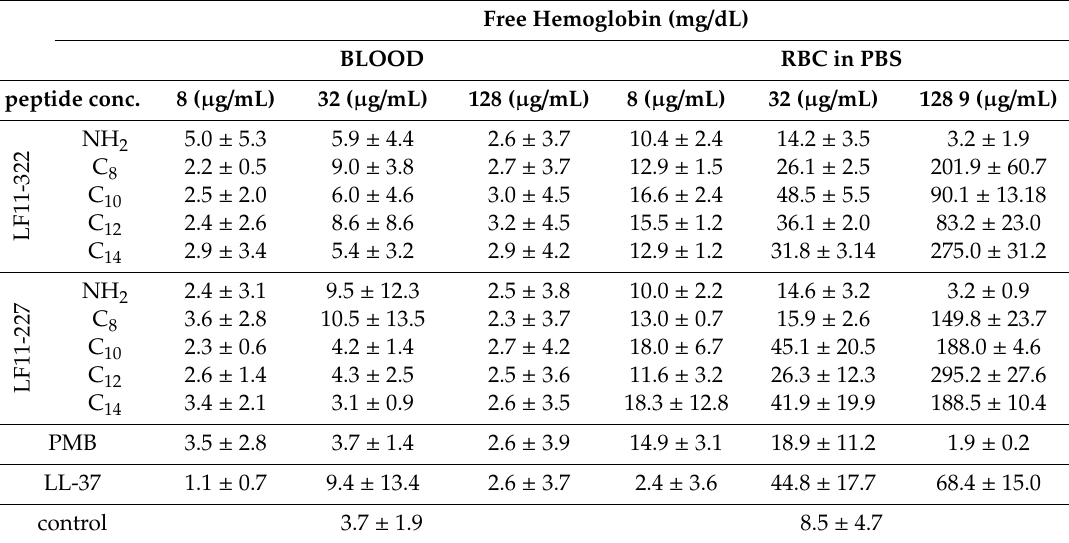
Table 2. Influence of AMPs on erythrocyte membranes. Hemolysis was measured in whole blood and in aqueous red blood cell suspension (RBC) at di ff erent AMP and PMB concentrations. The free hemoglobin level was determined using the method of Kahn [24] ( n = 3). Free Hemoglobin (mg / dL) BLOOD RBC in PBS peptide conc. 8 ( µ g / mL)